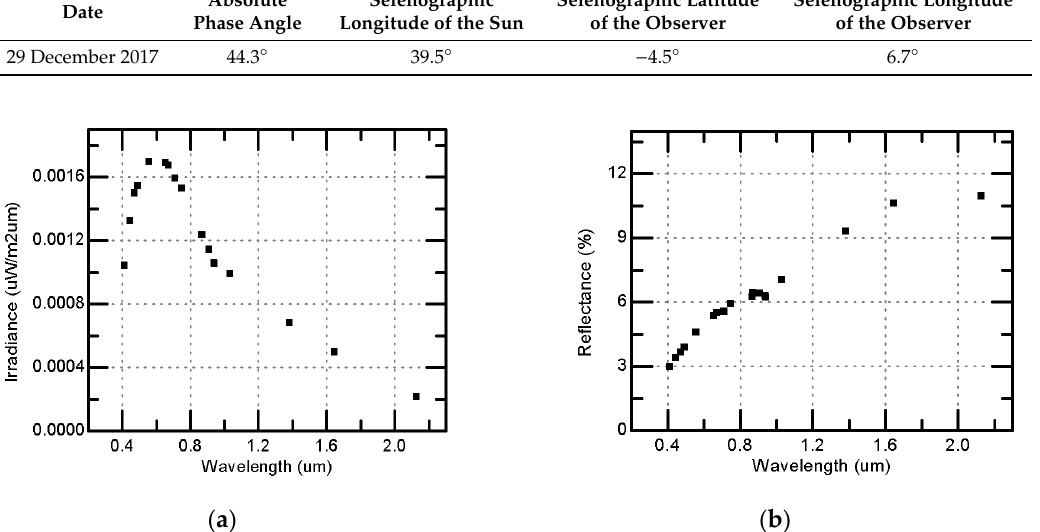
Figure 5. Lunar irradiance and reflectance for MERSI bands simulated by GIRO (29 December 2017). ( a ) X -axis is wavelength, and Y -axis is irradiance; ( b ) X -axis is wavelength, and Y -axis is reflectance.